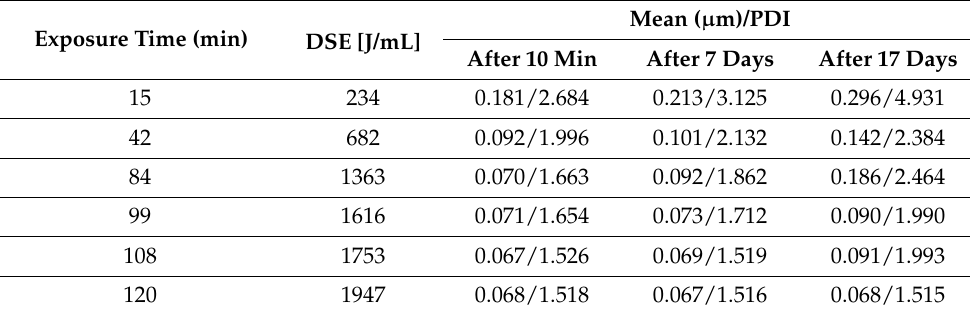
Table 2. Delivery of sonic energy (DSE), average particle size, and polydispersity index (PDI) for different ultrasonic exposure times (f = 396 kHz and P set = 102